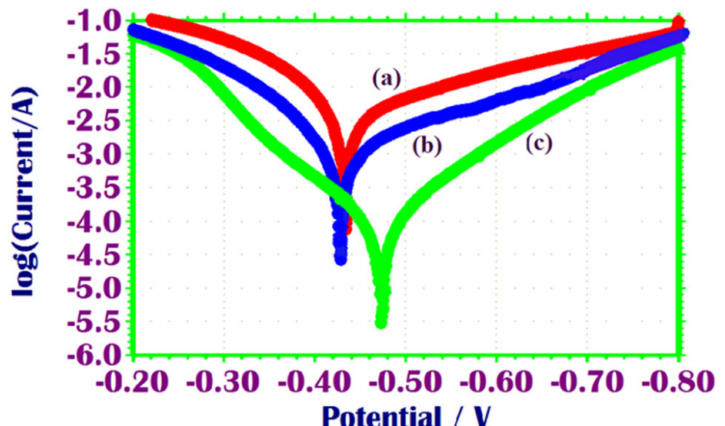
Figure 8. Potentiodynamic polarization curves for corrosion of mild steel in 1.0 M HCl ( a ) without inhibitor ( b ) with 2% and ( c ) with 10% aqueous leaf extract of